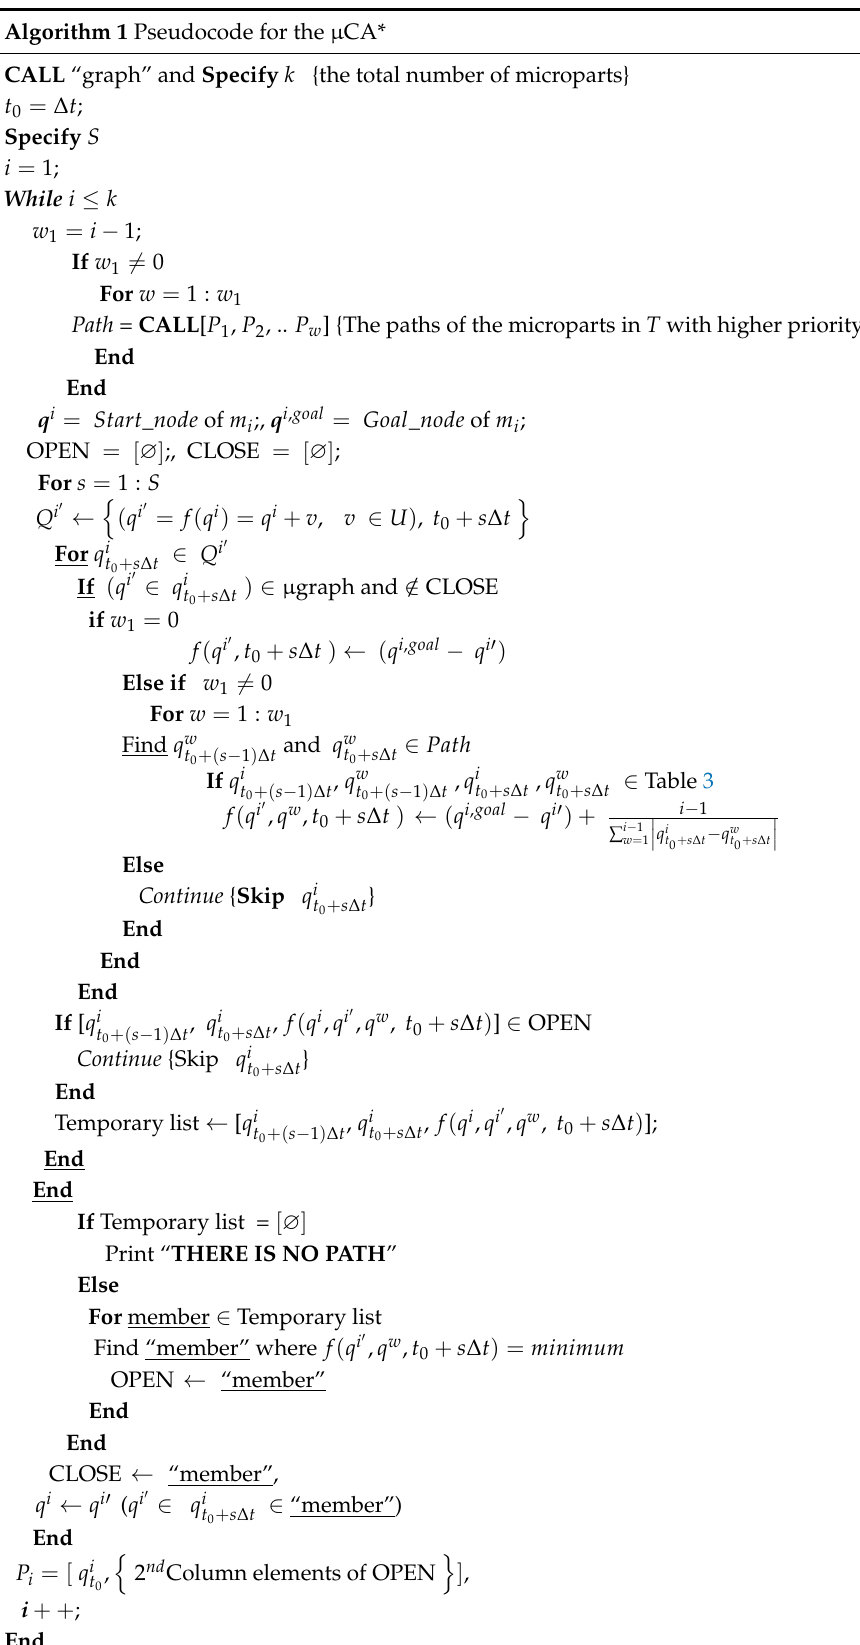
Algorithm 1 Pseudocode for the µ